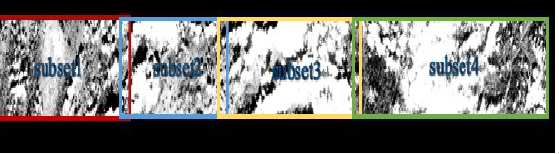
Figure 3. Block processing of DISP images